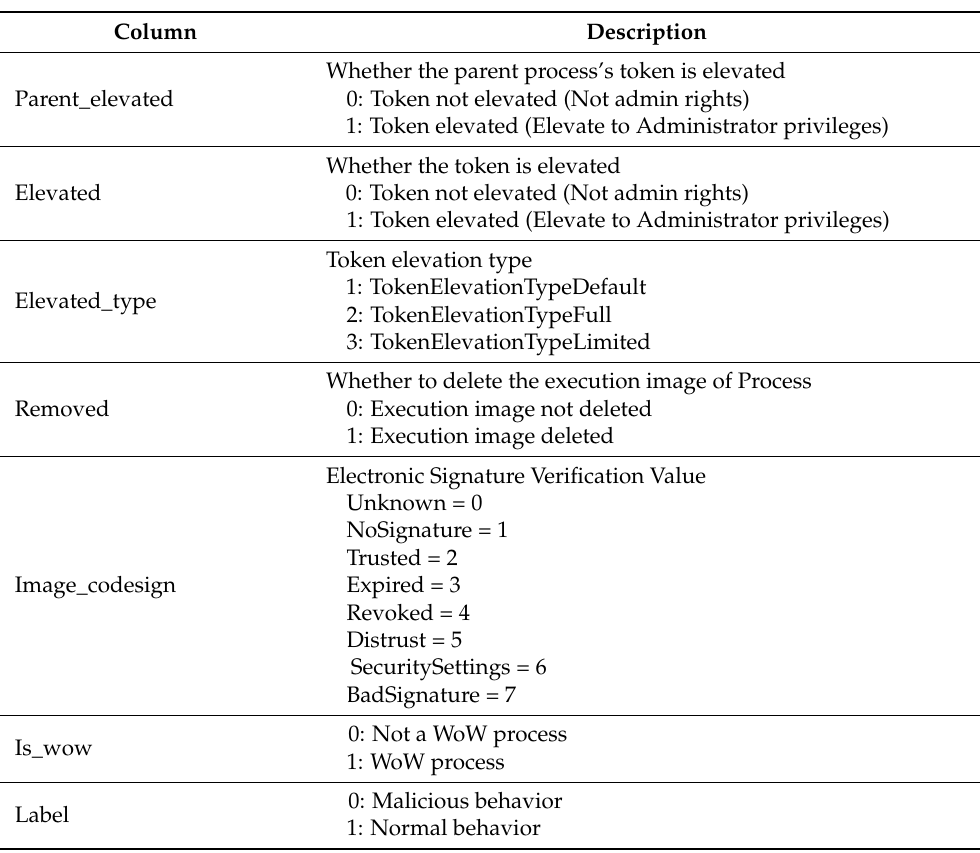
Table 3. Normal and abnormal behavior data column